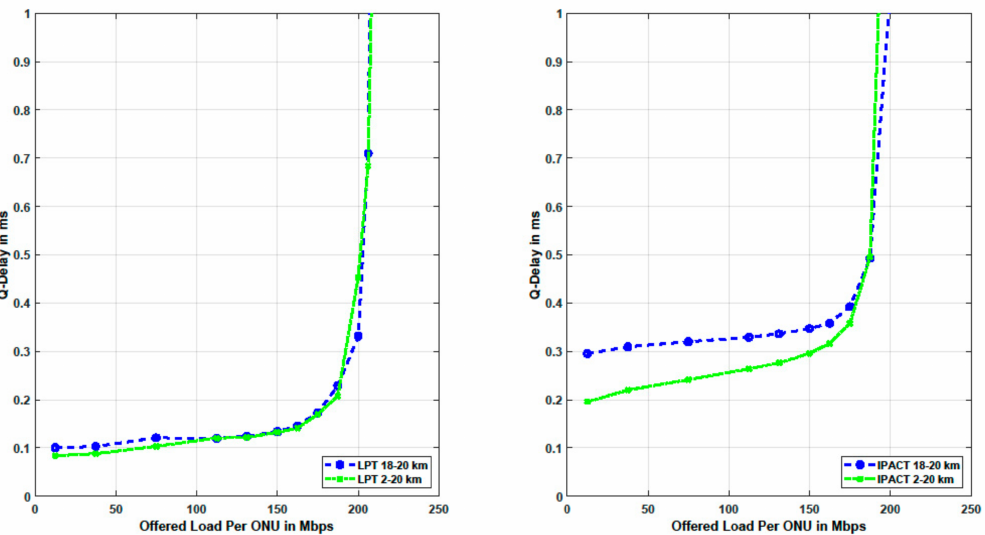
Figure 10. Queue delay for a 16-ONU system with a distance range of 2–20 km vs. 18–20 km at LTT = 10 µ s; LPT ( left ) and IPACT ( right